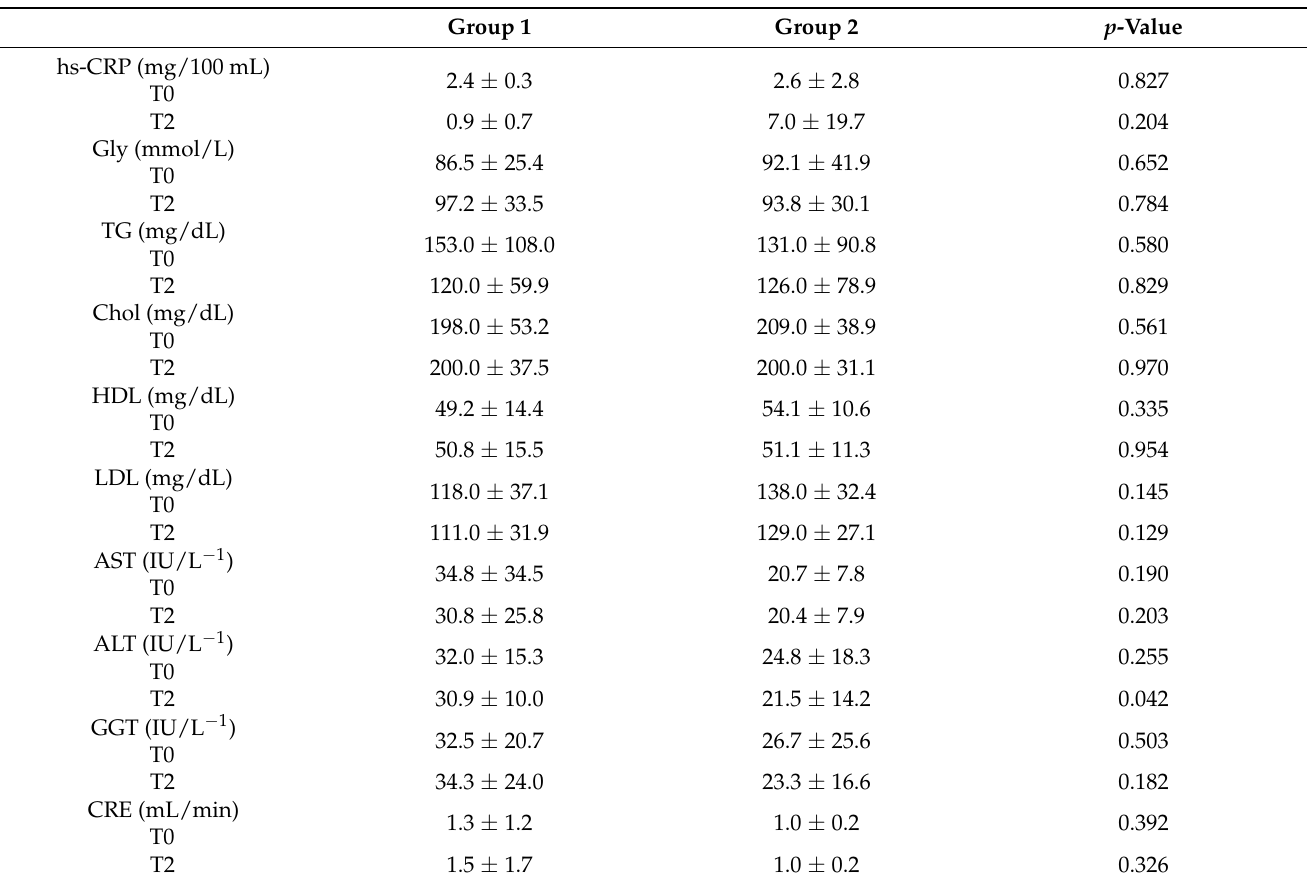
Table 2. Inflammatory and metabolic parameters in HIV+ patients at T0 (basal levels), T1 (after four weeks of supplementa- tion), and T2 (after eight weeks of supplementation and four weeks post-immunization). Data are reported as mean ± SD. p -values derived from the contrasts’ analyses are shown in